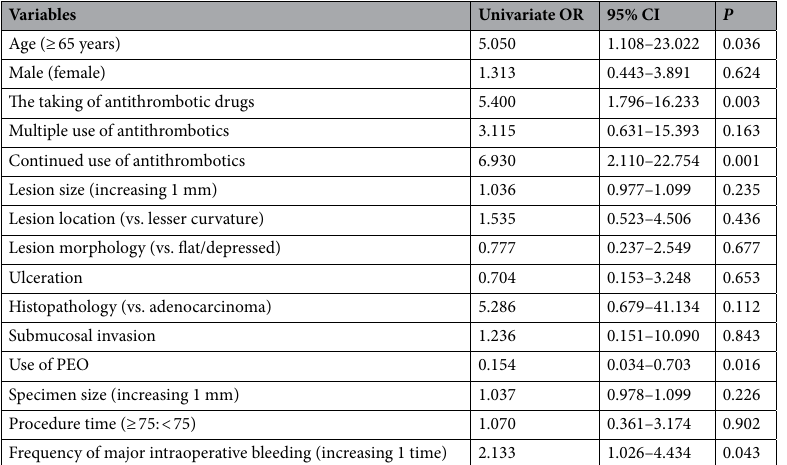
Variables Univariate OR 95%